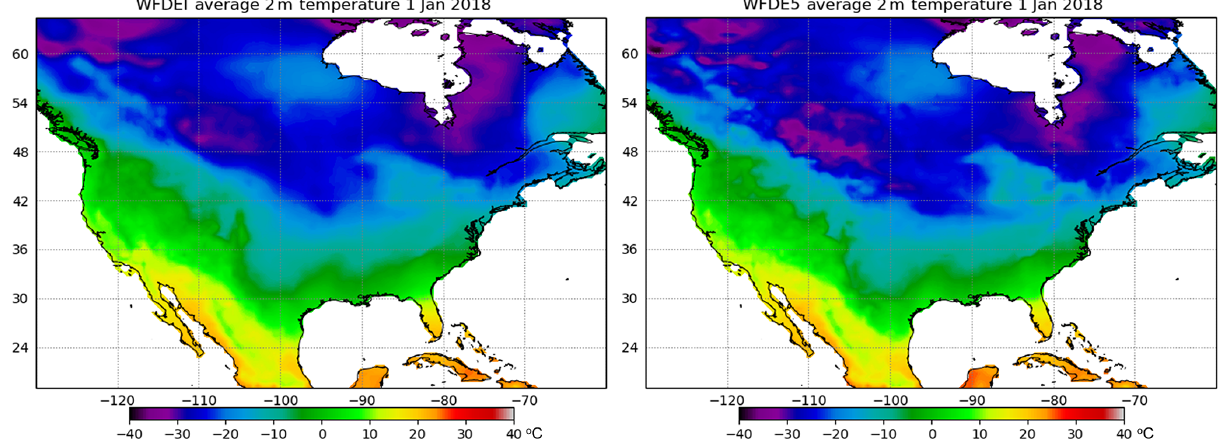
(Table 5), model efficiency (Fig. 4), and river discharge sea- sonality for selected large river basins (Fig.